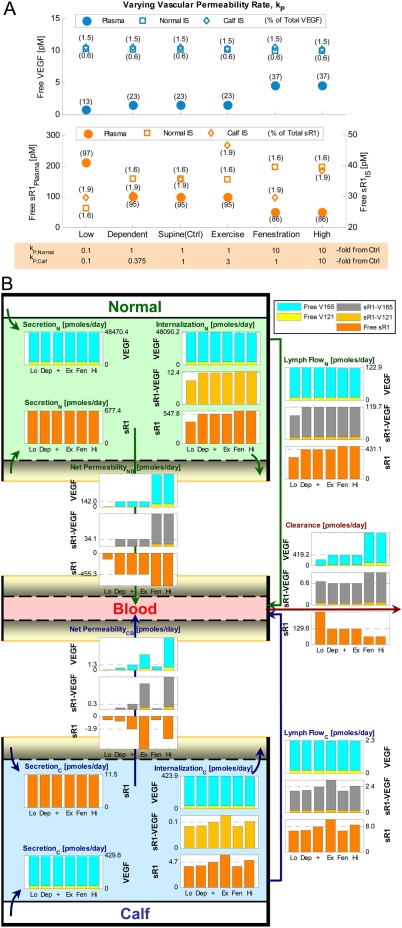
Steady-State Effects of Permeability Rate (kP) on VEGF and sVEGFR1 Concentrations (A) & Flows (B).In general, with increasing kP, concentrations changed in the directions that reduced transendothelial gradients: (i) plasma VEGF concentration increased; (ii) plasma sVEGFR1 decreased and interstitial sVEGFR1 increased. Exceptions were observed with localized changes in kP – e.g., increasing only kP,Normal from ‘supine(ctrl)’ to ‘fenestration’ enhanced sVEGFR1 extravasation into the normal compartment in expense of that into the calf, causing non-uniform changes in interstitial sVEGFR1 concentrations (increased locally, decreased distally). ‘Lo’ = low; ‘Dep’ = dependent; ‘+’ = supine (control); ‘Ex’ = exercise; ‘Fen’ = fenestration; ‘H’ = high.